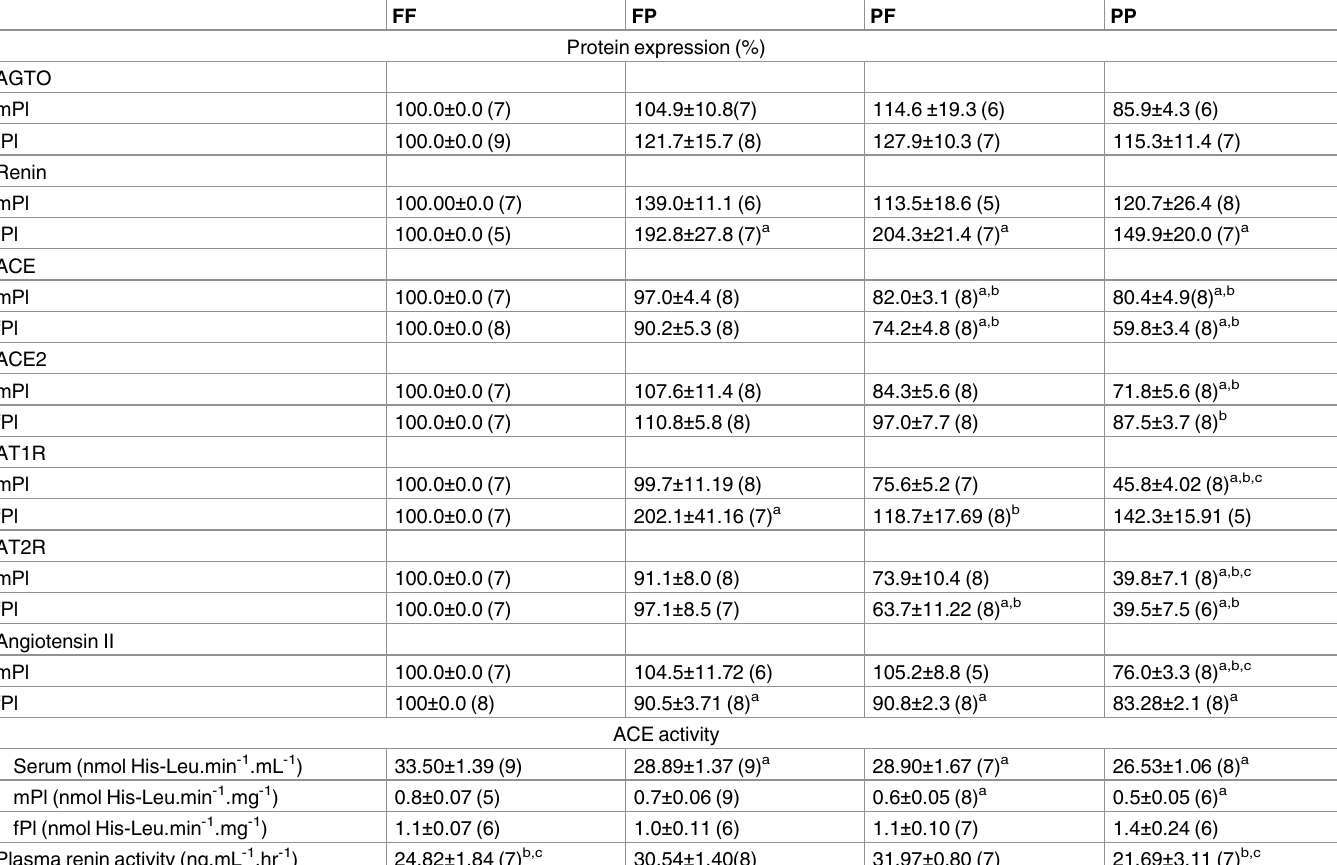
Table 5. Protein expression of AGTO, renin, ACE, ACE2, AT1R and AT2R receptors, angiotensin II and ACE and plasma renin activities in the maternal and fetal portions of the placenta. FF FP PF PP Protein expression (%) AGTO